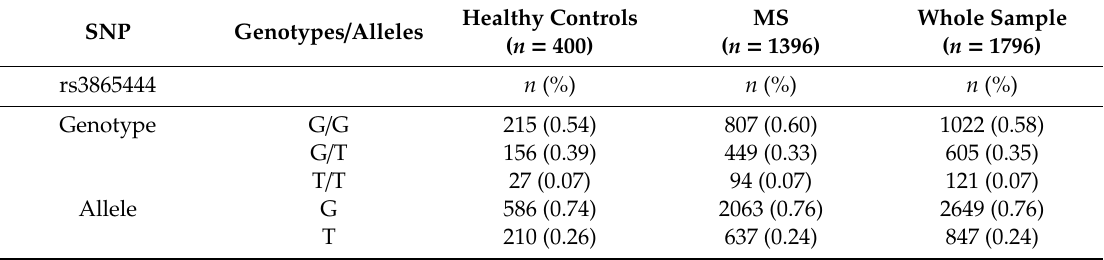
Table 2. Allelic and genotype frequencies of CD33 rs3865444 in healthy controls, in MS cases, and the whole sample.